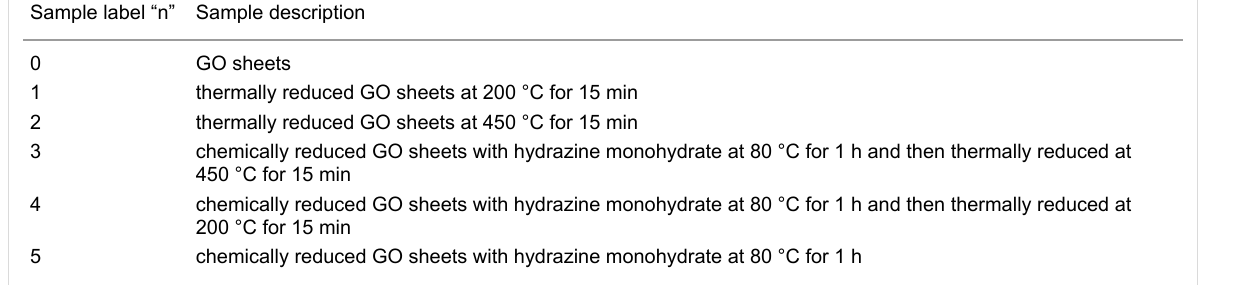
Table 1: Sample labels and corresponding